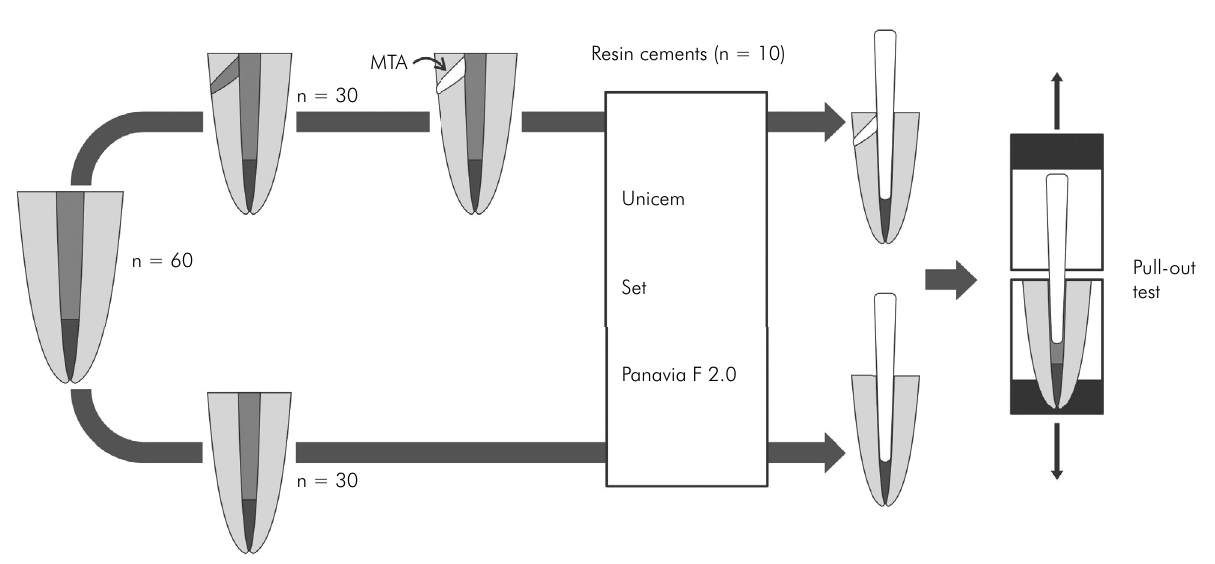
Figure 1. Experimental